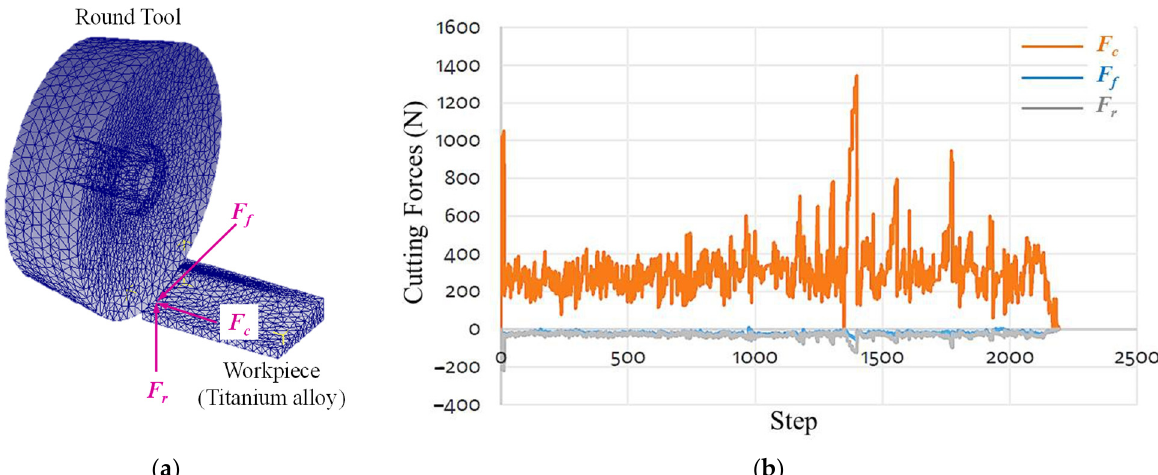
Figure 2. ( a ) FEM simulation of turning with the ADRT and ( b ) maximum cutting forces obtained (cutting conditions: cutting speed ( V w ) 60 m/min, feed ( f ) 0.2 mm/rev, depth of cut ( a p ) 0.2 mm, tool